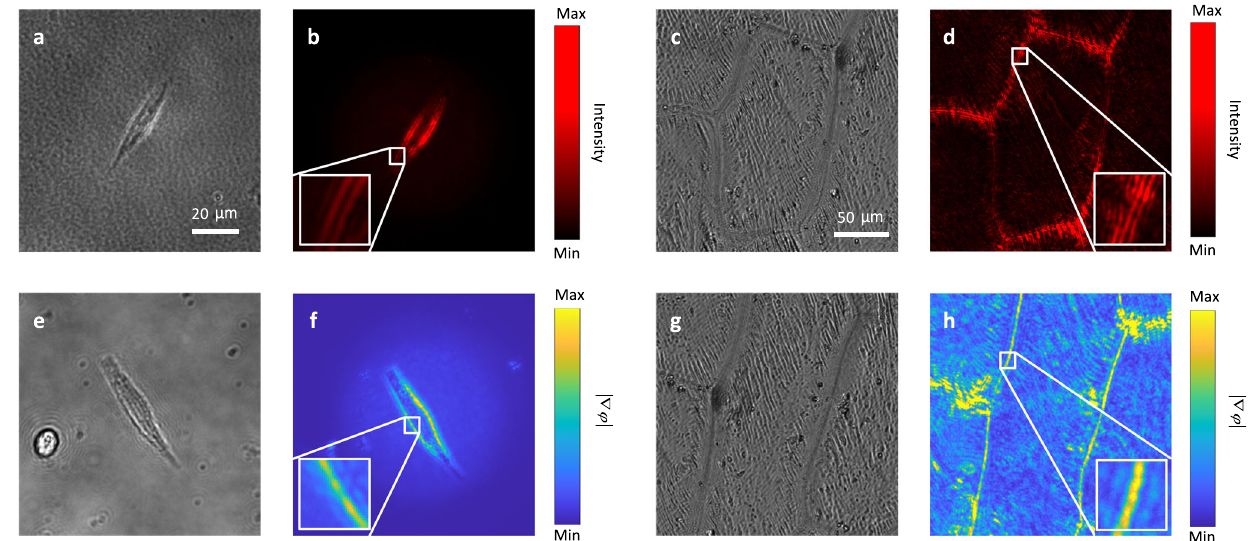
Fig.5|Performanceofmultiple-orderspatialdifferentiationforphaseobjects. Bright fi eld optical images of ( a ), ( e ) B16F10 melanoma cells and ( c ), ( g ) onion epidermis. b , d The second-order spatially differentiated images of the B16F10 melanoma cells and the onion epidermis, respectively. f , h The fi rst-order spatially